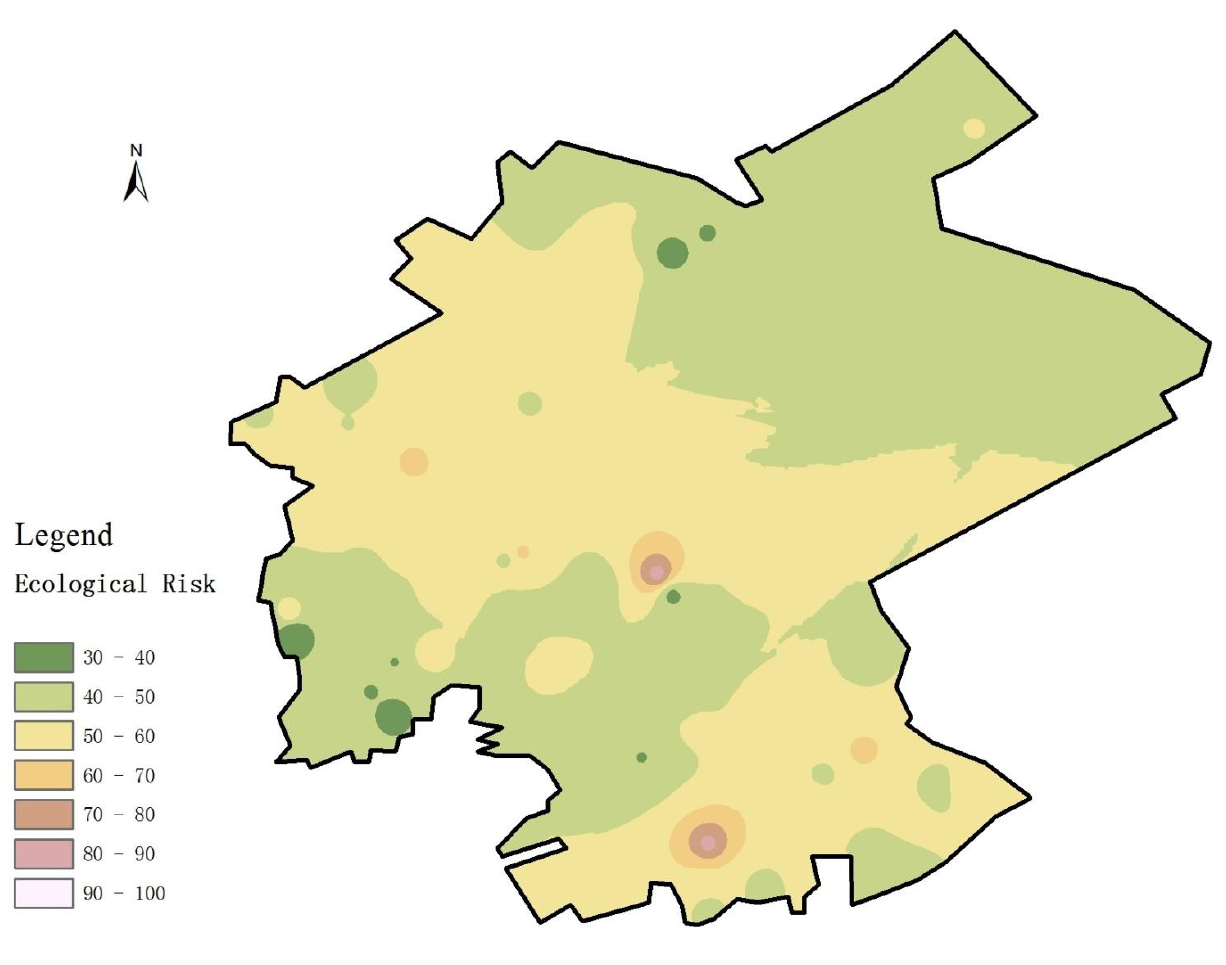
Figure 7. Spatial distribution map of